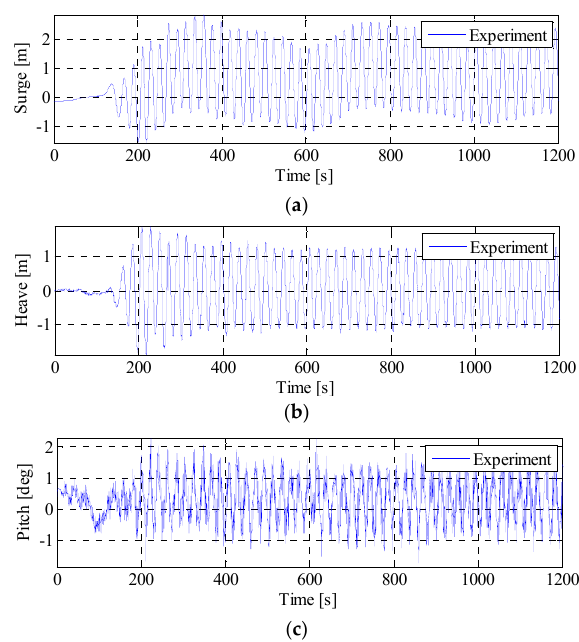
Figure 10. ( a ) Surge motion of the platform under the R2 in the 0 degree direction; ( b ) heave motion of the platform under the RW2 in the 0 degree direction; ( c ) pitch motion of the platform under the R1 in the 0 degree direction.